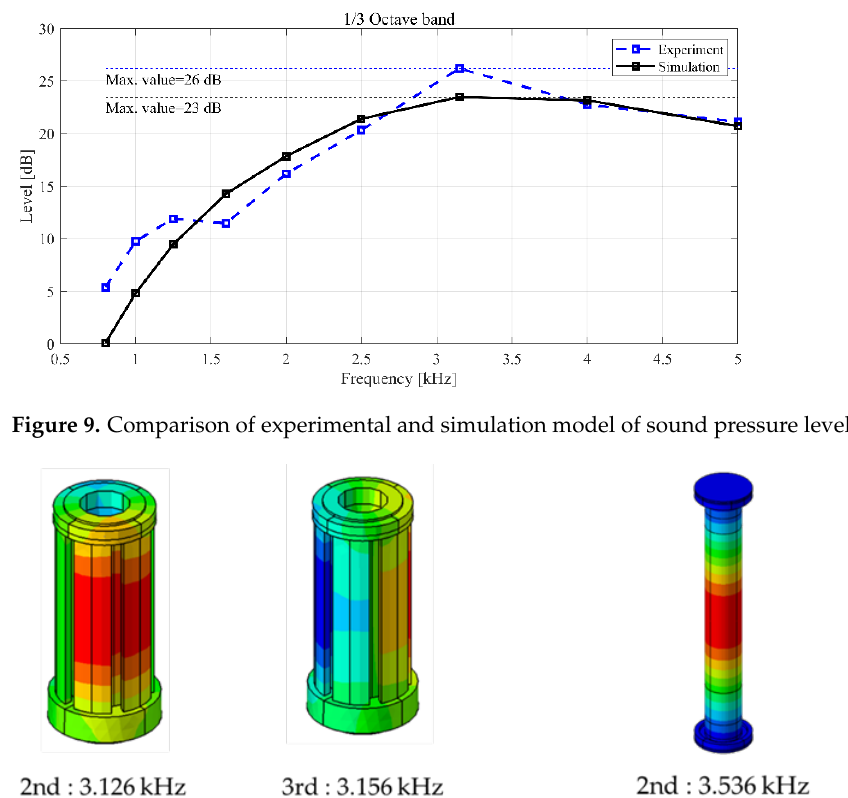
Figure 9. Comparison of experimental and simulation model of sound pressure level.